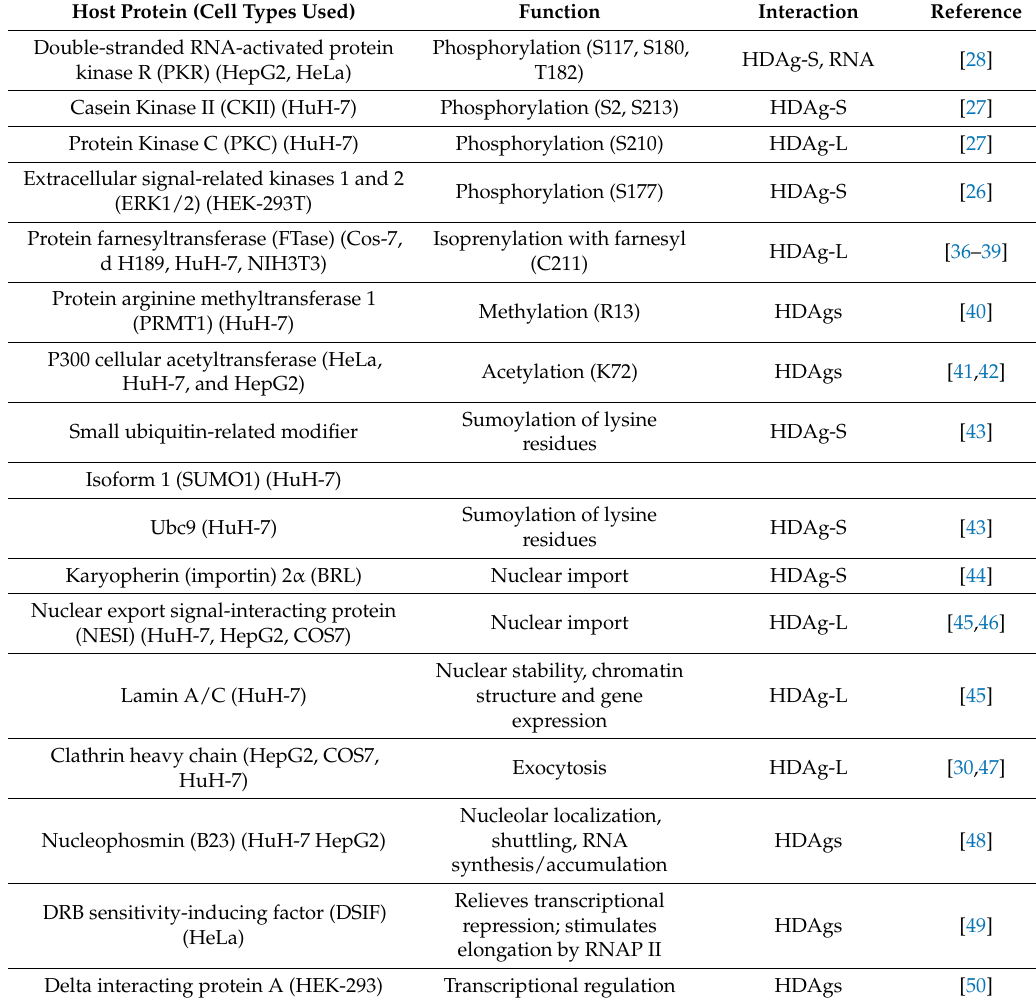
Table 1. Host protein interacting with HDV RNA and/or